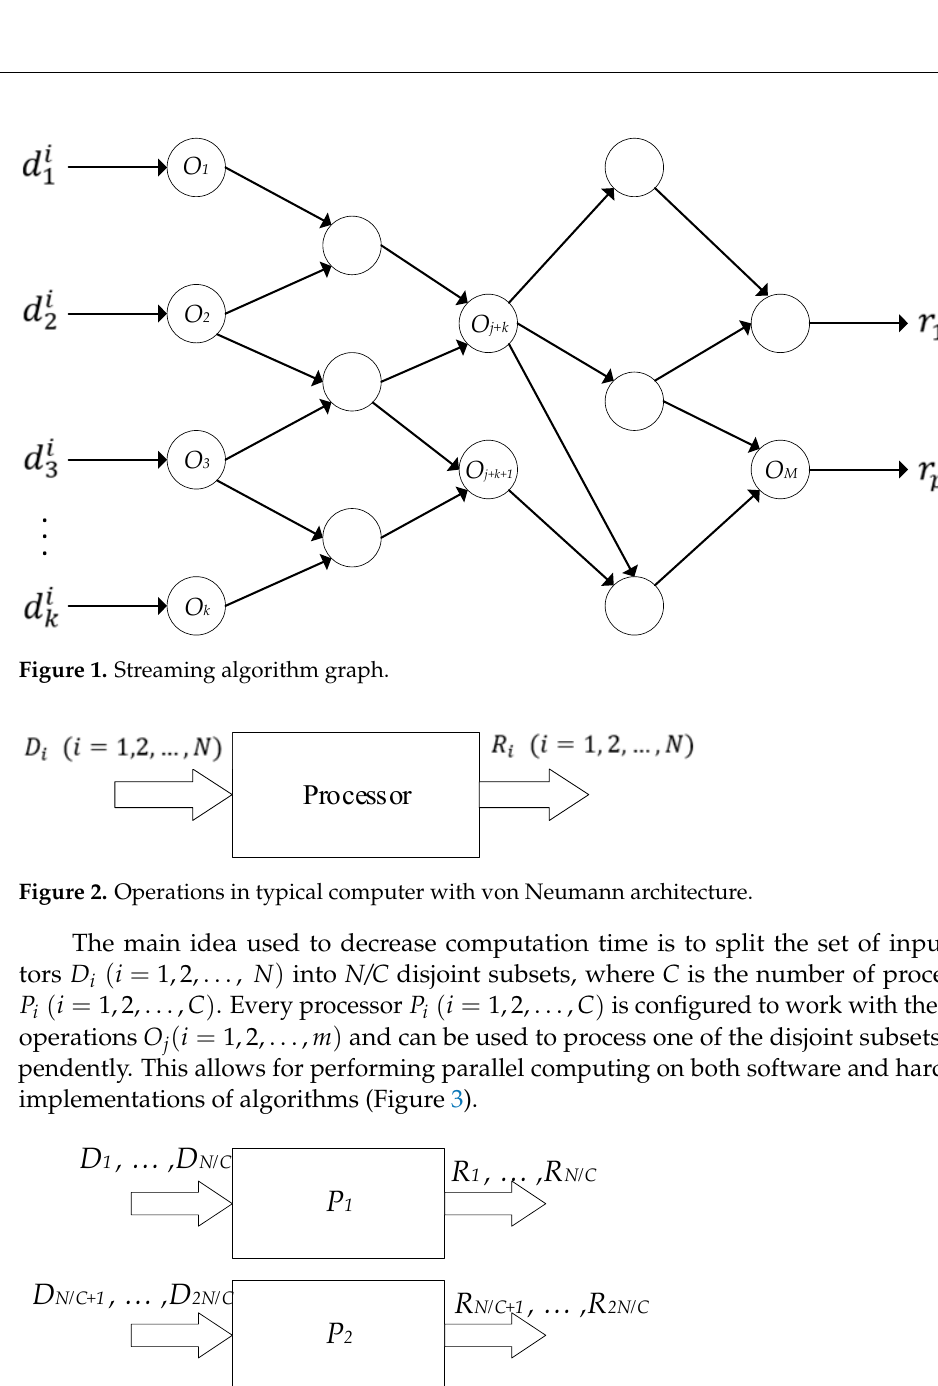
Figure 1. Streaming algorithm graph.